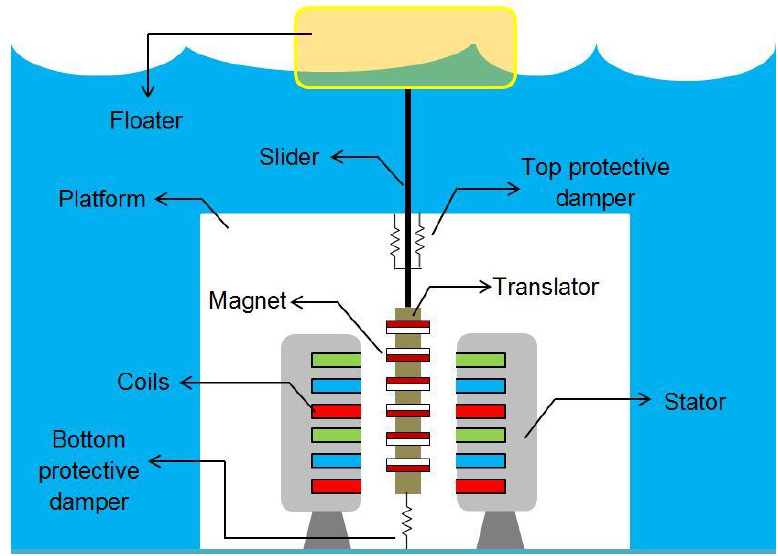
Figure 2. Placement of the proposed direct-drive WEC.